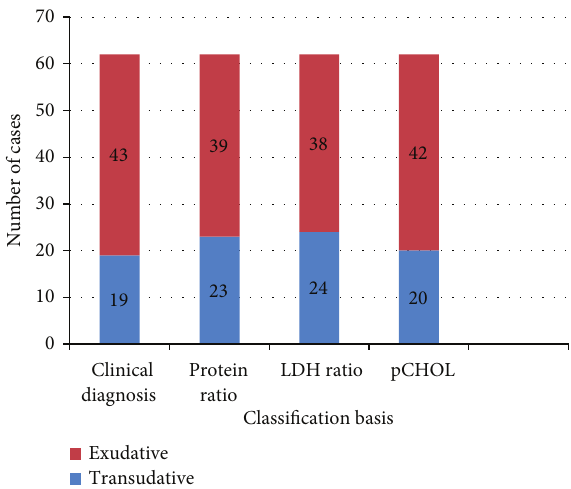
F 5: Cases classi�ed by Light’s criteria and pCHOL with clinical